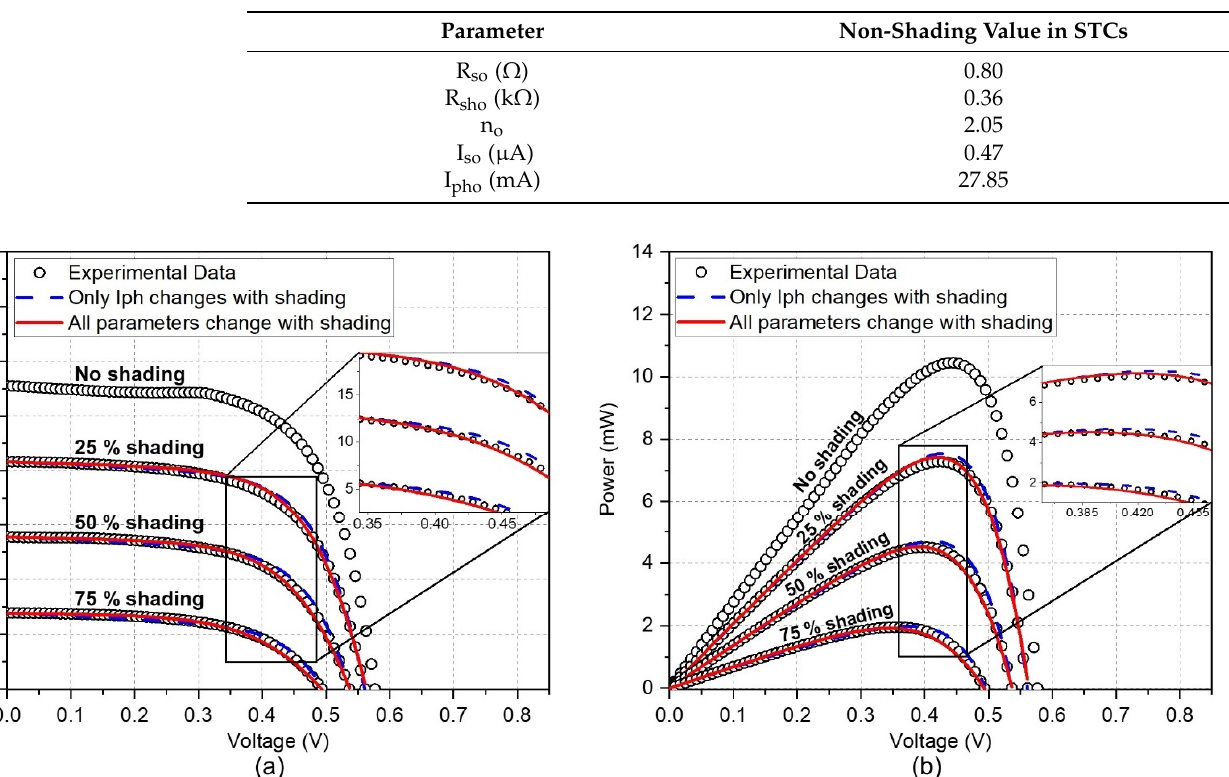
Figure 7. Experimental and calculated I-V and P-V curves of the solar cell under different shading. The black circles are experimental results. The red solid lines represent the calculated results that consider the variation of all parameters with shading. The blue dashed lines represent the calculated results that consider the variation of I ph only: ( a ) I-V curves; ( b ) P-V curves. Each experimental curve is the average of three measurements under a light irradiance of 1000 W/m² at a cell temperature of 25 °C.